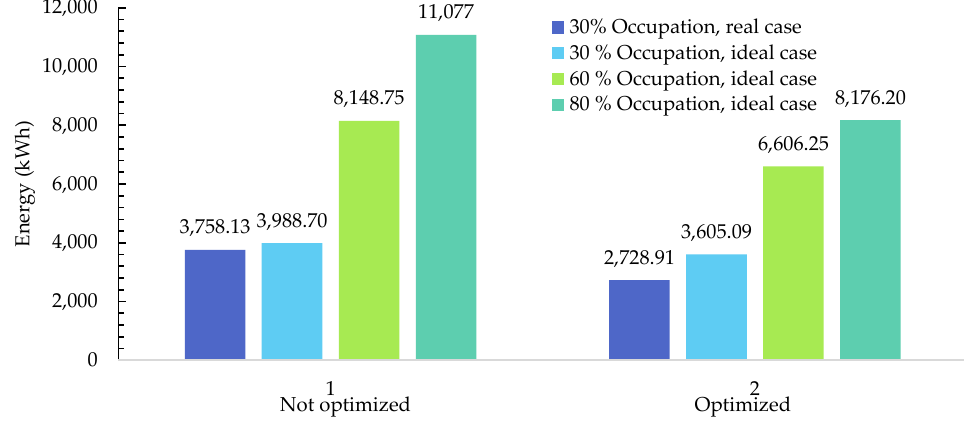
Figure 18. The energy supplied as a percentage of occupancy of recharging